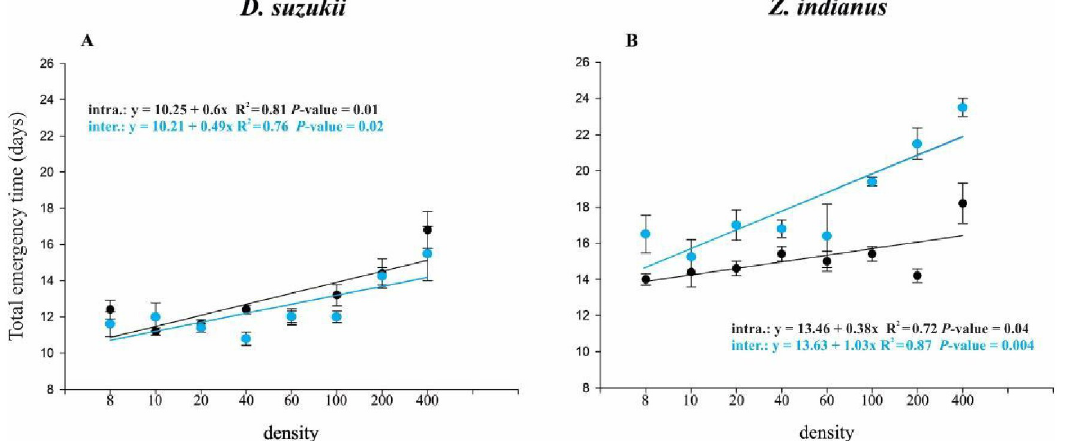
Fig 4. Development time. Mean emergence times of Drosophila suzukii (D) and Zaprionus indianus (Z) fitted to regression functions in the 8 different densities. The black line and points represent intraspecific competition; the blue line and points represent interspecific